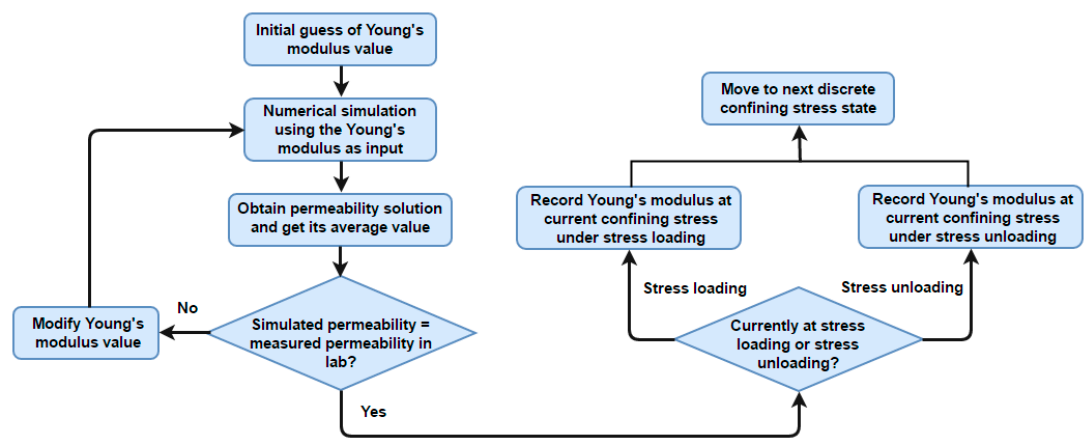
Figure 4. Nonlinear elasticity calibration workflow based on adjustment of elastic modulus values.